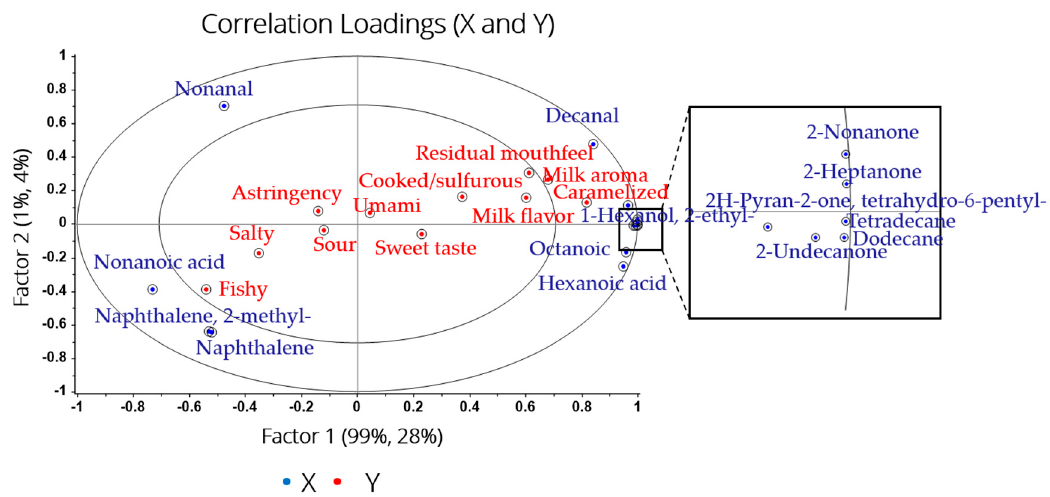
Figure 6. PLSR plot of correlation between volatile compounds and sensory attributes from three kinds of skim milk samples.